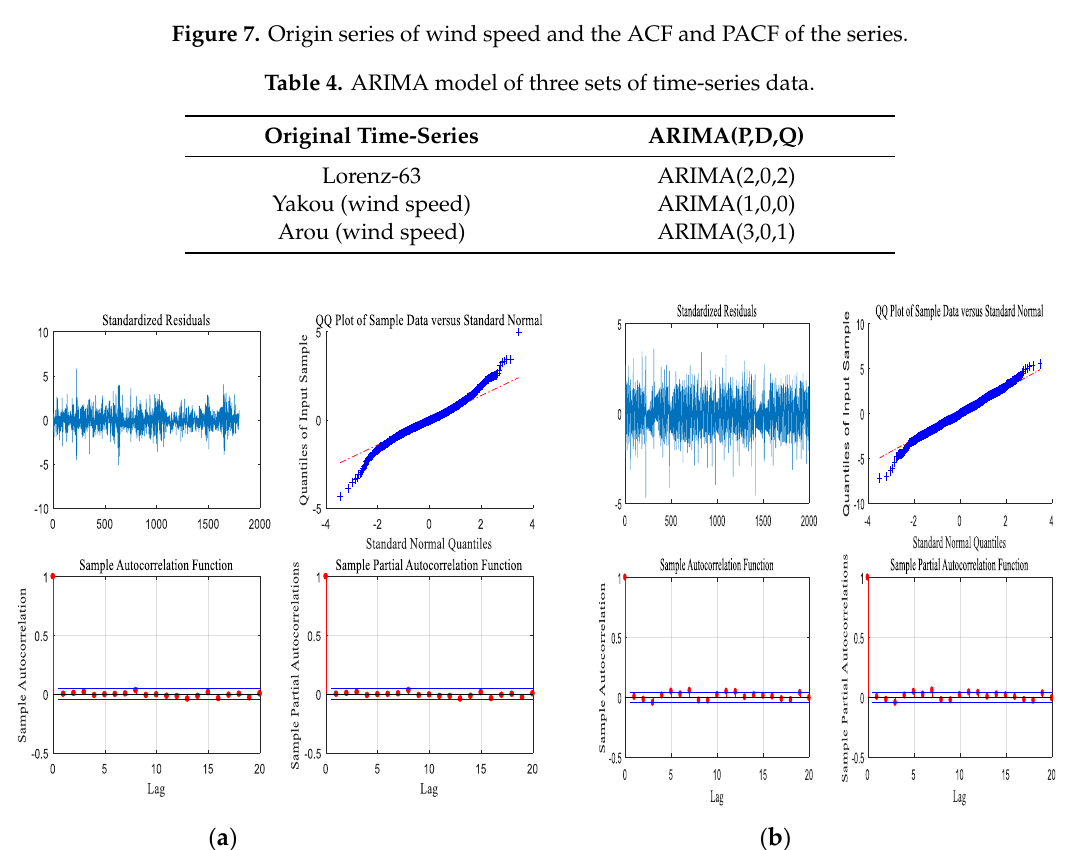
Figure 8. The residual test of wind-speed data after modeling. (a) Yakou site; (a) Arou site. Table 4. ARIMA model of three sets of time-series data.